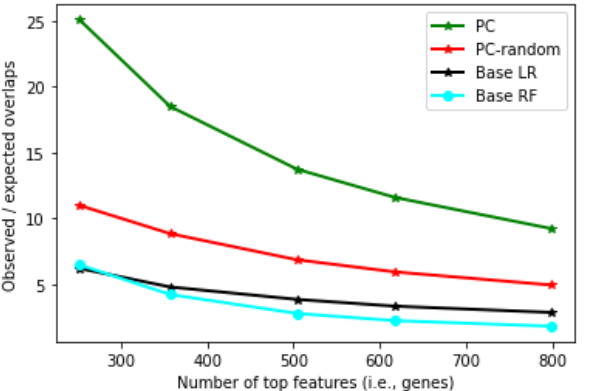
Figure 9. Robustness measure (y-axis) for Personalized LR, Base LR and Base RF at different numbers of top features (x-axis).